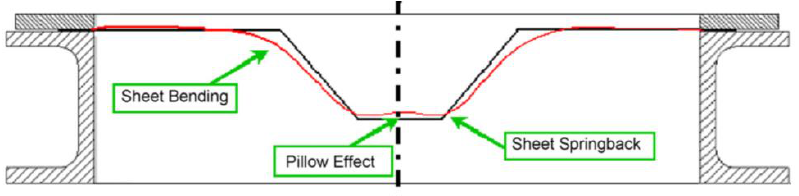
Figure 9. Geometrical errors during the incremental forming of a conical drawpiece (adapted with permission from Ref. [80], 2007, copyright Elsevier B.V.). permission from Ref. [80], Copyright 2007 Elsevier